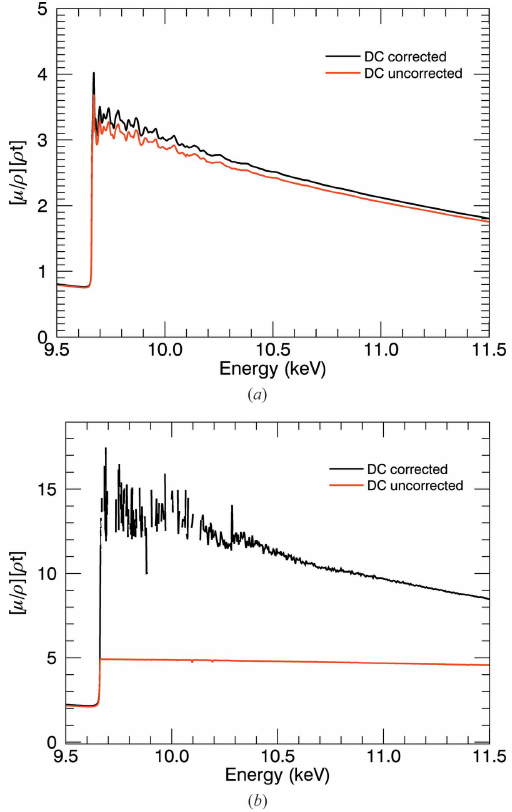
Figure 5 The effect of correcting for dark current in the 10 K data for the ( a ) 10 m m foil and ( b ) 50 m m foil. At 10 m m, the largest displacement is near the absorption edge. The largest glitch in the uncorrected data, near to 10.1 keV, disappears after correction for dark current. For 50 m m, correcting for the dark current reveals some consistency in the spectra at high k . It is quite important to monitor the dark current through a spectral data